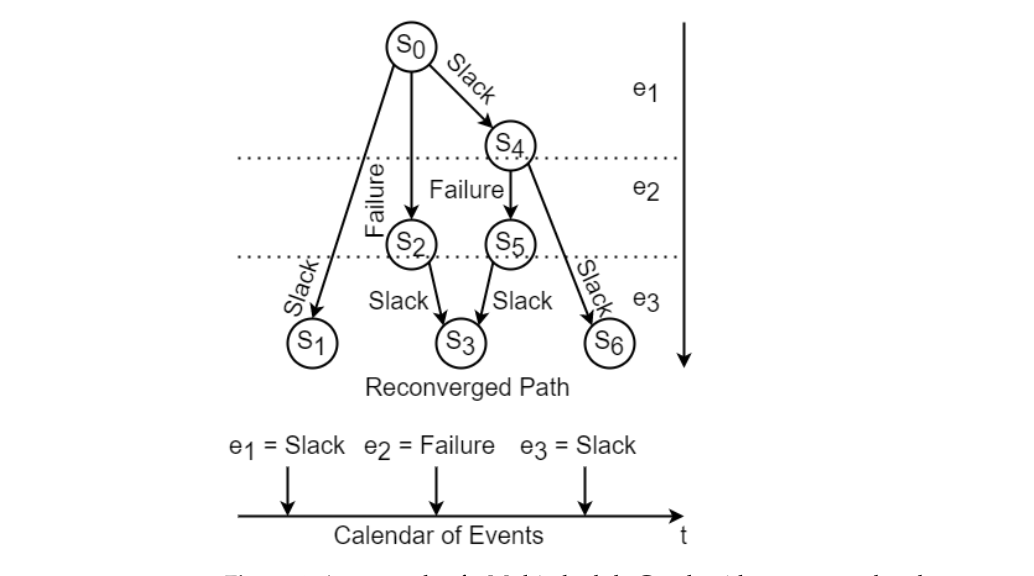
Figure 4. An example of a Multischedule Graph with reconverged path. Algorithm 2: GA-based Metascheduler with reconvergence of paths in